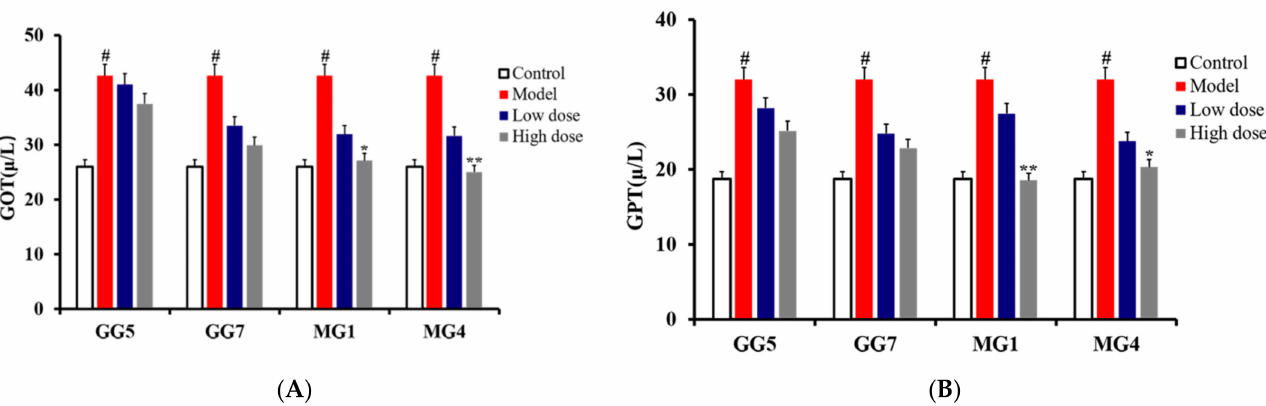
Figure 6. Effect of Ginseng on the activity of GOT ( A ) and GPT ( B ) in the serum of rats with liver injury induced by paclitaxel (compared with control group, # p < 0.05; compared with model group, * p < 0.05 and ** p <